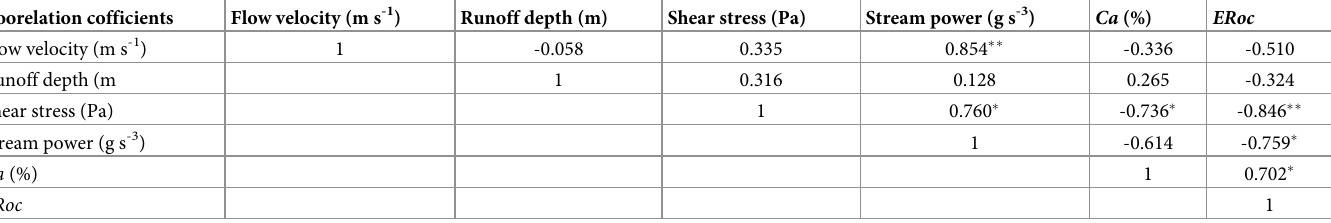
Table 4. Pearson correlation analysis results of flow hydraulic characteristics, contribution of unevenly enriched orgainc carbon in sediments to ERoc ( Ca ) and ERocs